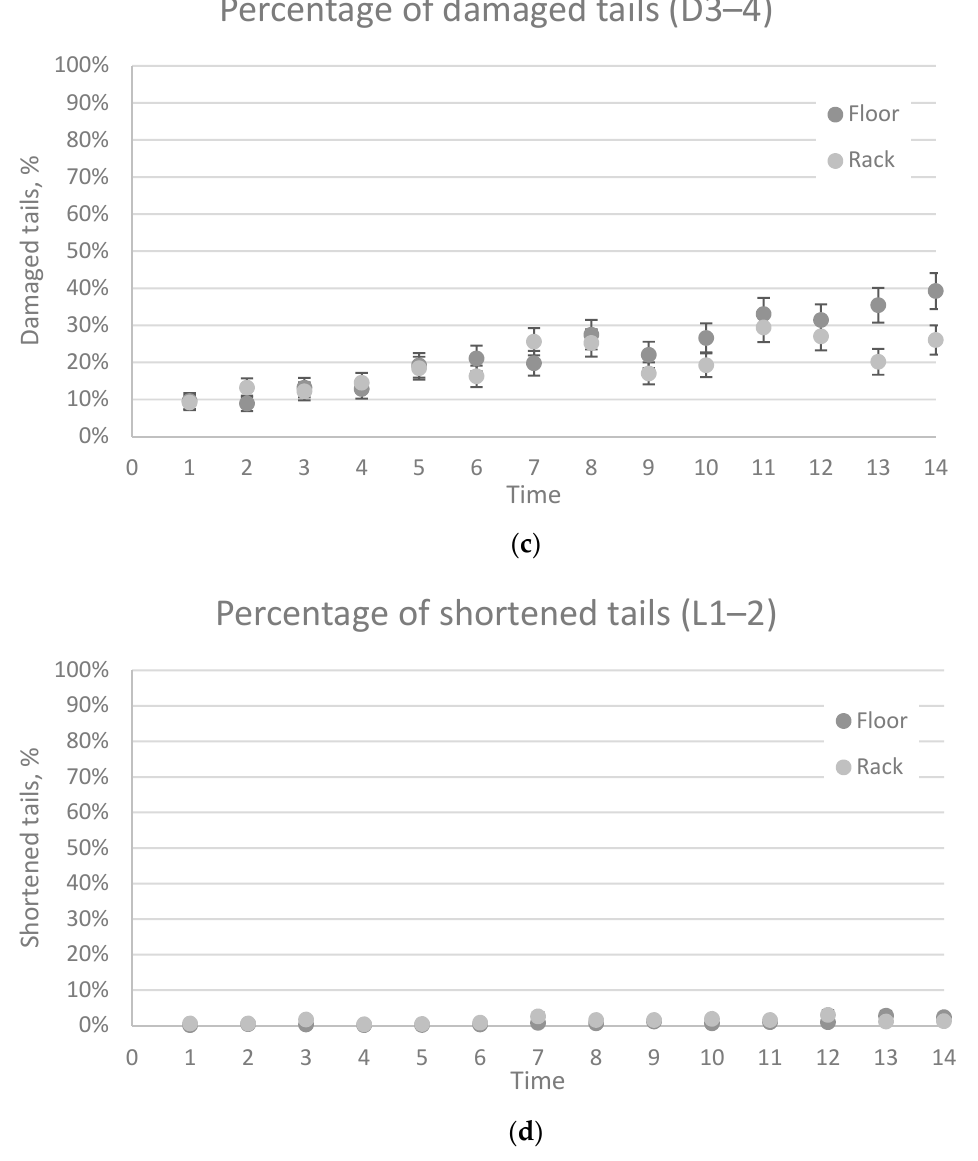
Figure 3. Interaction between percentages of pigs with damaged tails and time ( a – c ), percentage of shortened tails and time ( d ). Time refers to the time of data collection, which was done once per week during the production period (1–14). The error bars are standard error means and visualizes where there is a difference between the two treatments. ( a ) Percentage of damaged tails with damage score D1–D4, ( b ) percentage of damaged tails D2–4, ( c ) percentage of damaged tails D3–4, and ( d ) percentage of shortened tails (L1–L2). For explanation of damage and length scores, see Table 2. N tot = 6139, N Time1 = 459, N Time2 = 458, N Time3 = 455, N Time4 = 451, N Time5 = 541, N Time6 = 452, N Time7 = 450, N Time8 = 448, N Time9 = 448, N Time10 = 447, N Time11 = 433, N Time12 = 433, N Time13 = 377, N Time14 = 376.